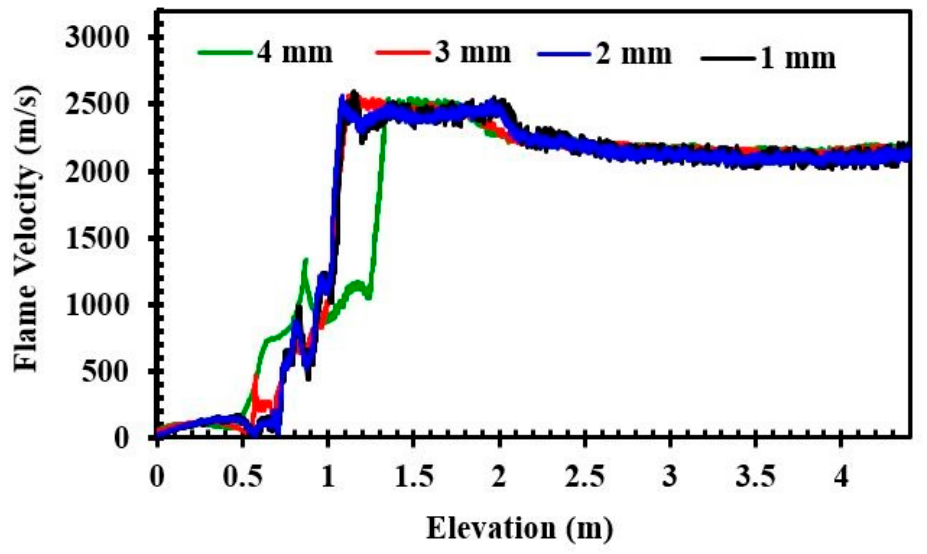
Figure 4. Mesh sensitivity analysis of H 2 –air mixture with 30% hydrogen concentration for different computational grids .